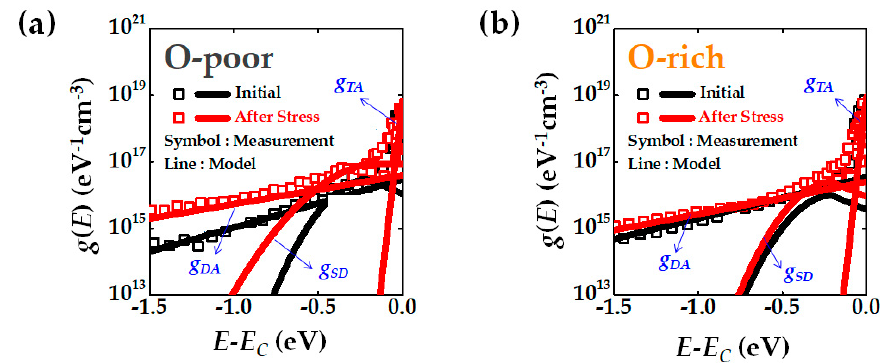
Figure 7. Extracted DOS distributions before and after stress: ( a ) The DOS change of O-poor device; ( b ) The DOS change of O-rich device.